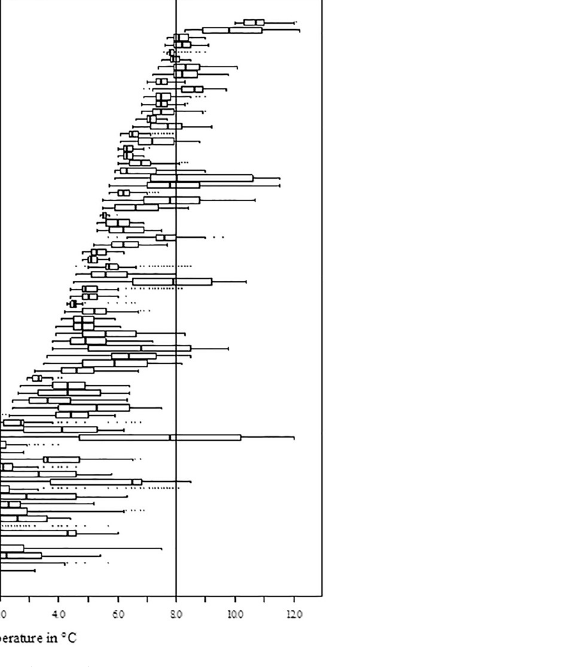
Fig 2. Temperature ranges per refrigerator (N = 75).